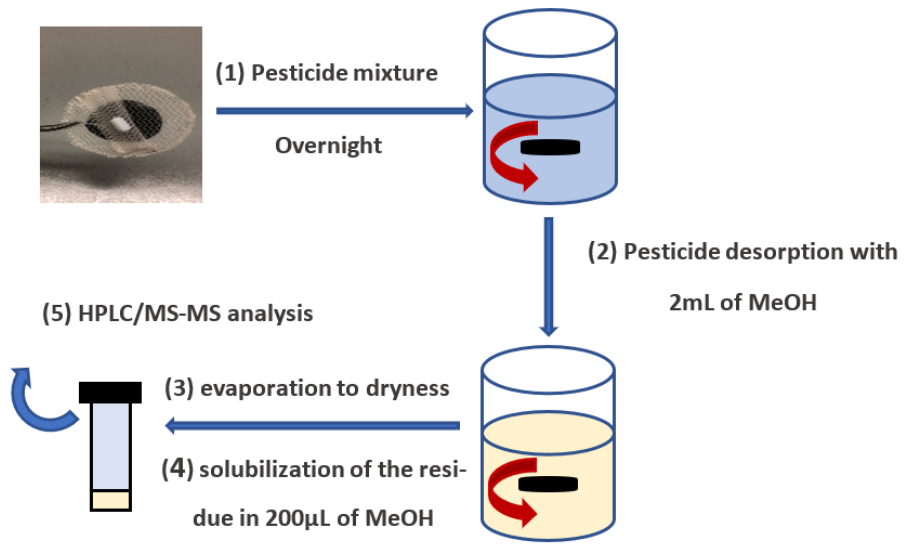
Figure 7. Scheme of the pesticide-extraction procedure.